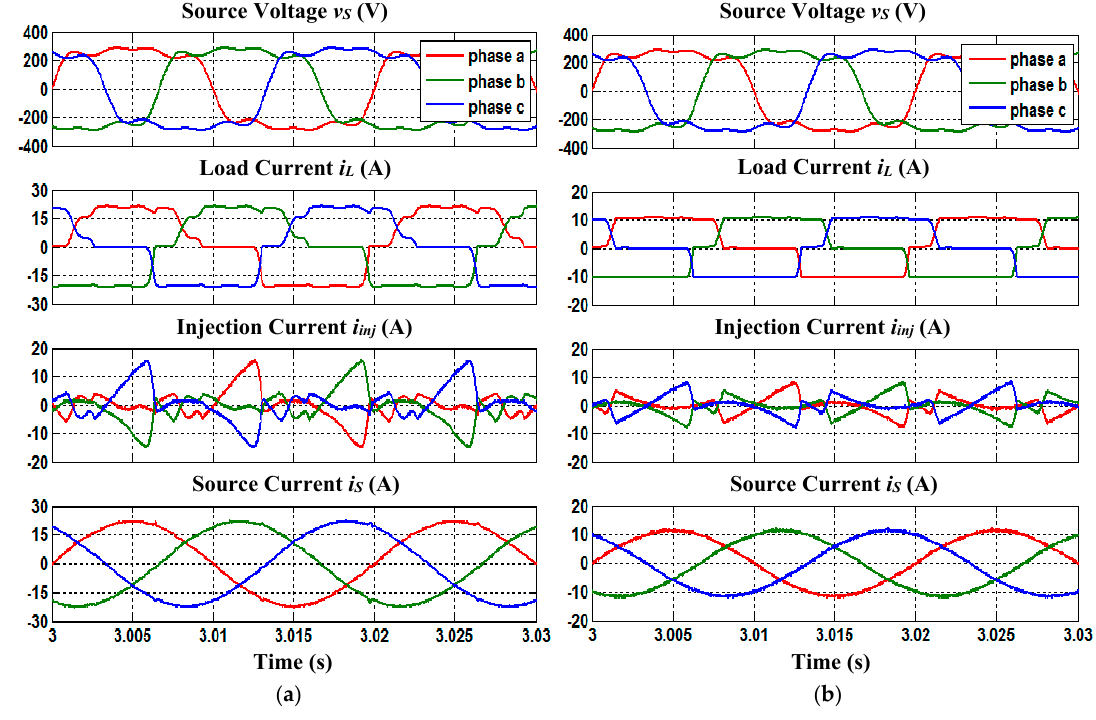
Figure 4. Steady-state simulation waveforms (case 2) of SAPF utilizing the refined STF-pq theory algorithm which include three-phase source voltage v S , load current i L , injection current i inj and source current i S for ( a ) resistive and ( b ) inductive loads.